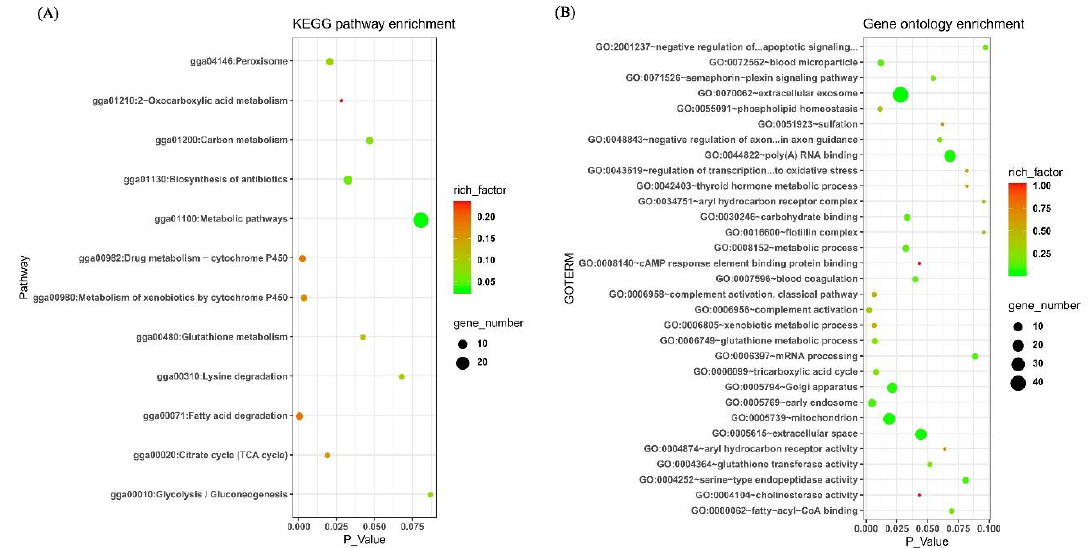
Figure 4. Kyoto Encyclopedia of Genes and Genomes (KEGG) and Gene Ontology (GO) analyses with differentially expressed genes between the livers of the Tibet chicken embryo and the lowland chicken embryo in a simulated hypoxic hatchibator with 13% oxygen concentration at the end of day 16 of incubation. ( A ) KEGG pathway analysis; ( B ) GO analysis.